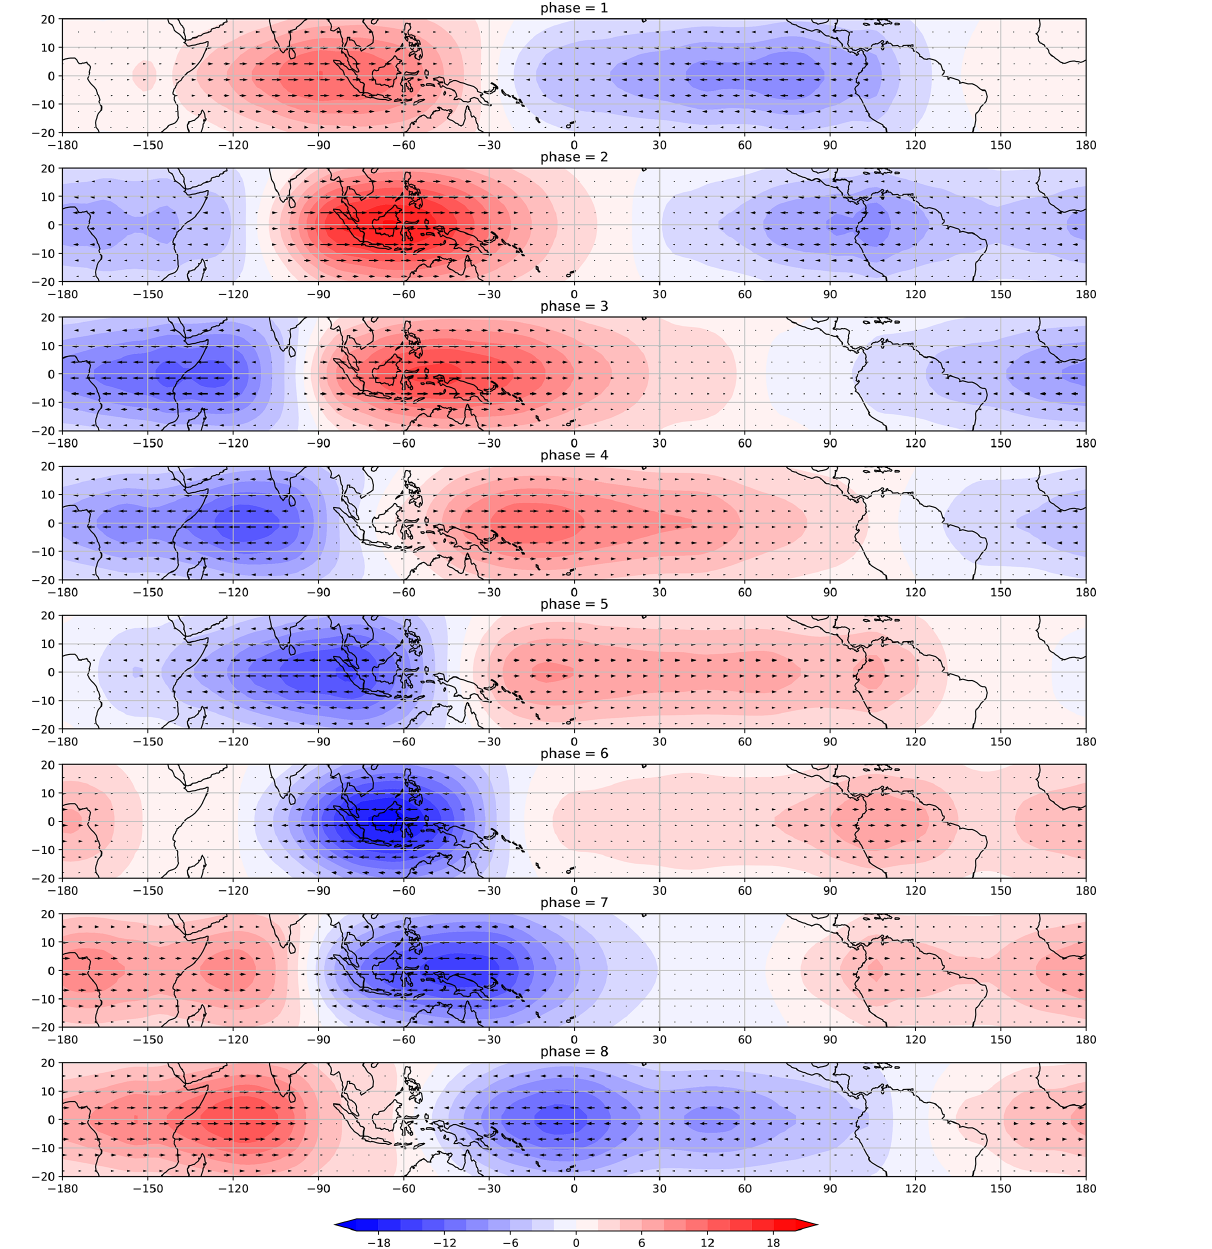
Figure 14. Reconstruction at 200Mb of the velocity and geopotential height fields associated with Kelvin modes with SZW30 −